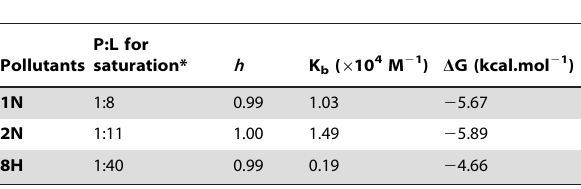
Table 2. Binding parameters of naphthol titrations to HSA in 20 mM Tris–HCl pH 7.4 at 37 u C from UV–visible spectroscopic measurements.